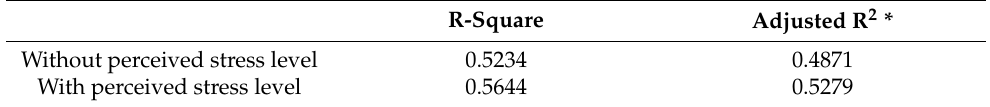
Table 4. Crude and adjusted R 2 for RQLQ scores in AR